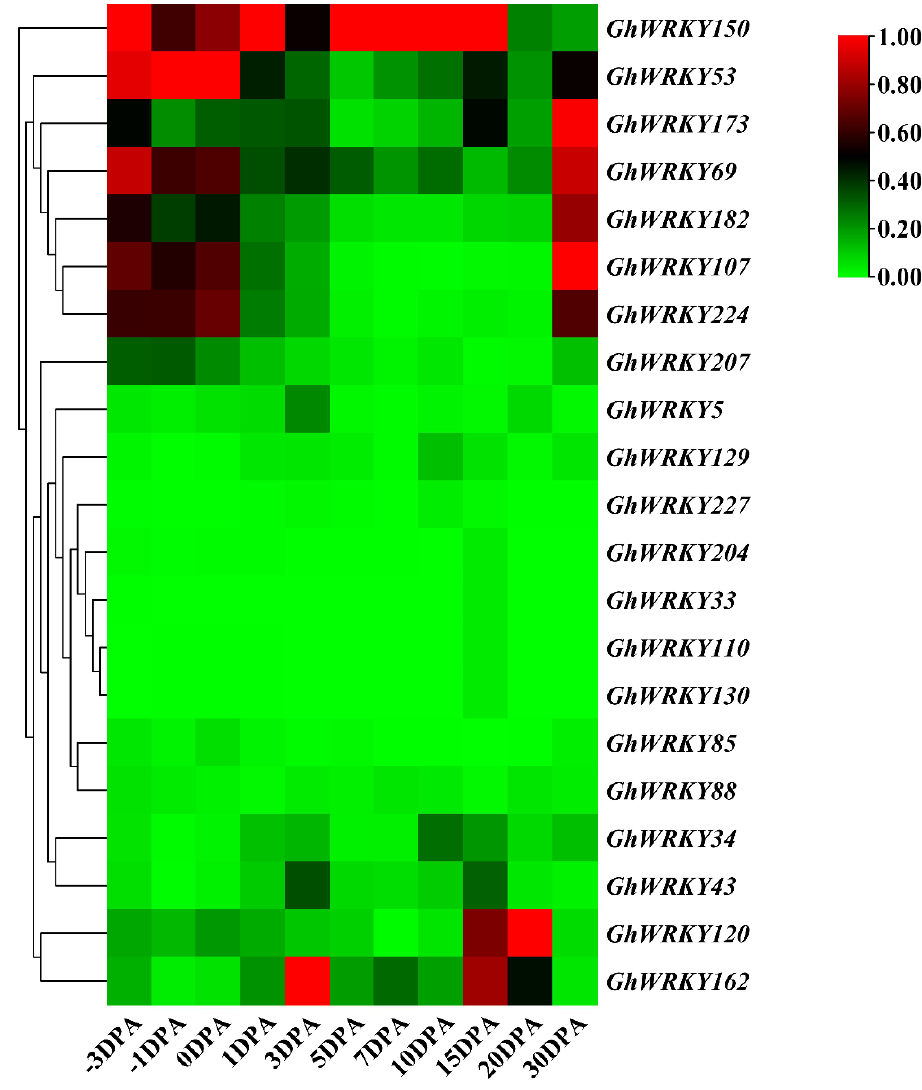
Figure 5. Expression profiles of group III WRKY genes during fiber development in G. hirsutum L. TM-1.